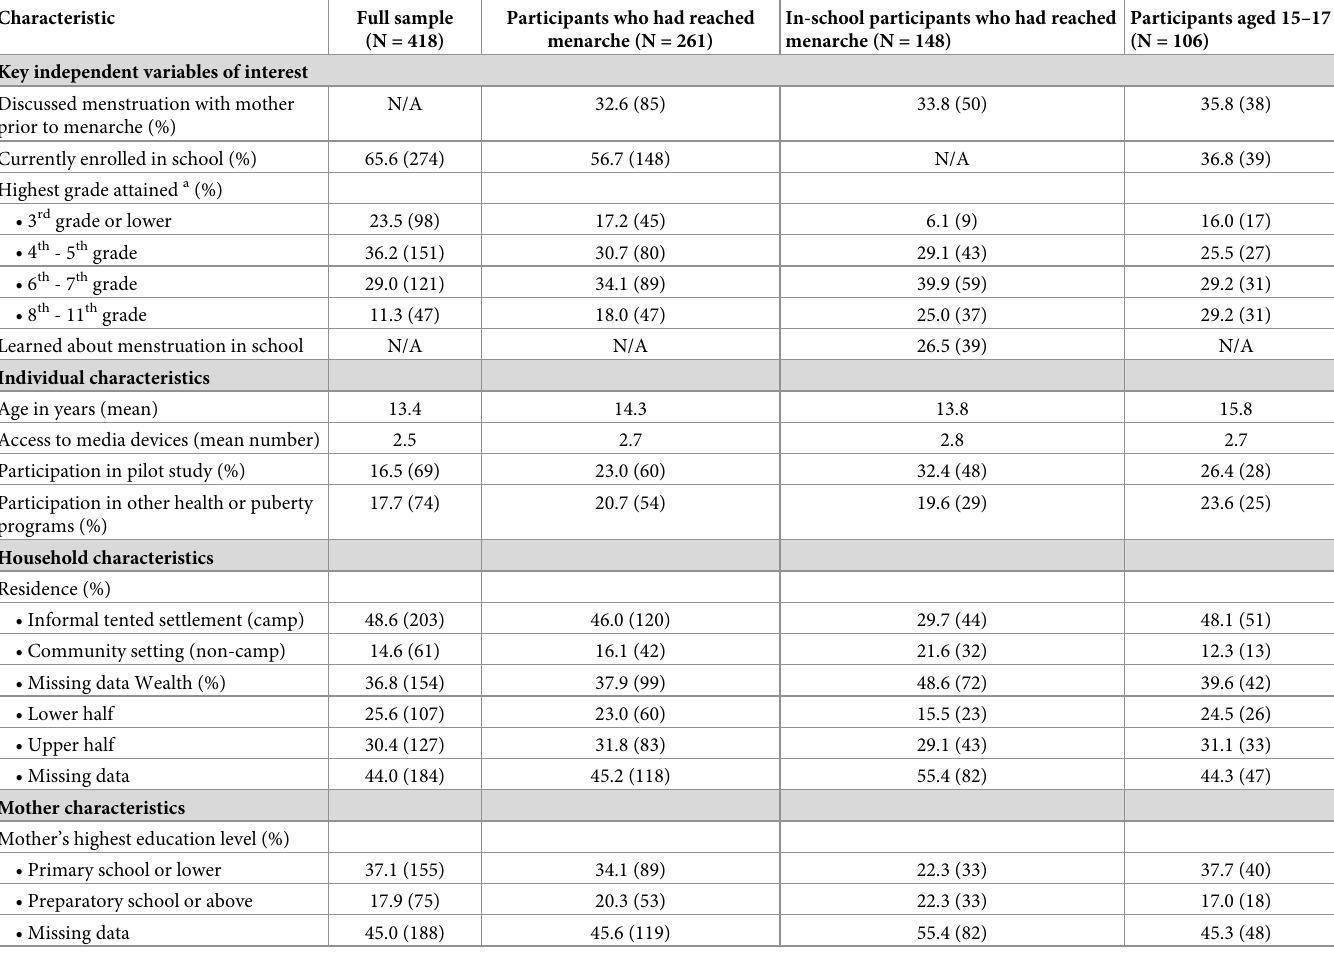
Table 1. Summary statistics for independent variables, full sample, girls who had reached menarche, in-school girls who had reached menarche, and girls aged 15– 17.